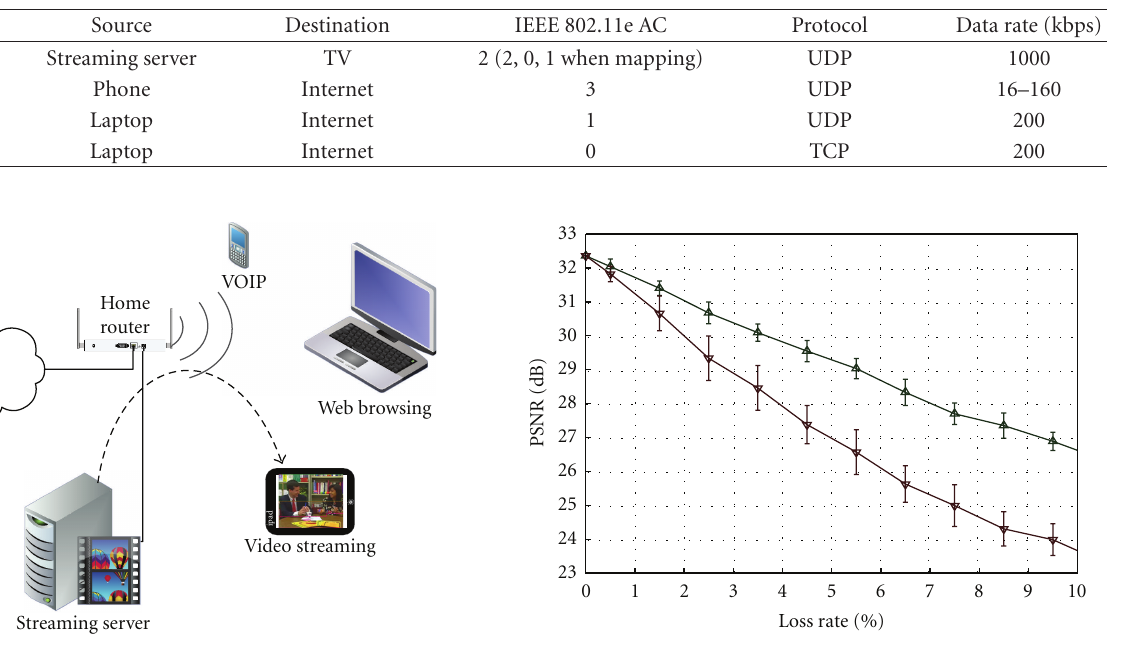
Figure 5: Simulated IEEE 802.11b test scenario.